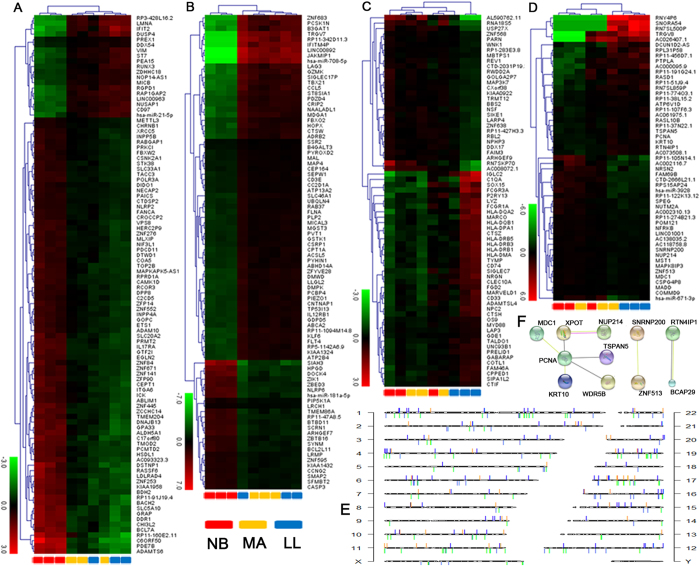
Validation of WGCNA models as robust classifiers for age-specific stages in four independent model datasets from the blue, turquoise, royal blue and dark orange modules.(A) Unsupervised clustering heatmap based on the top 99 transcripts and one miRNA (rows) of CD4+ T cells samples (columns) in the blue model dataset. Red and green indicate high and low expression levels, respectively. All of NB group clusters by themselves on the far left of the dendrogram. (B) Unsupervised clustering heatmap based on the top 86 transcripts and two miRNAs of CD4+ T cells samples in the turquoise model dataset. All of NB group clusters by themselves on the far left of the dendrogram. (C) Unsupervised clustering heatmap based on the top 69 transcripts of CD4+ T cells samples in the royal blue model dataset. None of the age-specific groups cluster by themselves on the dendrogram. (D) Unsupervised clustering heatmap based on the top 51 transcripts and two miRNAs of CD4+ T cells samples in the dark orange model dataset. All of LL group clusters by themselves on the far right of the dendrogram. Red and green symbolizing relative expression levels corresponding to the scale bar at the bottom left for (A–D). (E) Locations of the model-related transcripts and miRNAs (Model-RNAs). Transcripts and miRNAs were mapped to corresponding genomic coordinates on human chromosomes and are represented on an Ensemble-generated ideogram (Ensemble, hg19 genome build). Model-RNAs are colored in blue, turquoise, royal blue and dark orange, corresponding to their models. (F) A connected network illustrates Model-RNAs in the dark orange model that contained genes positively correlated to the age-specific phenotype. Layouts of the connected network are based on correlation information annotated in the STRING database.